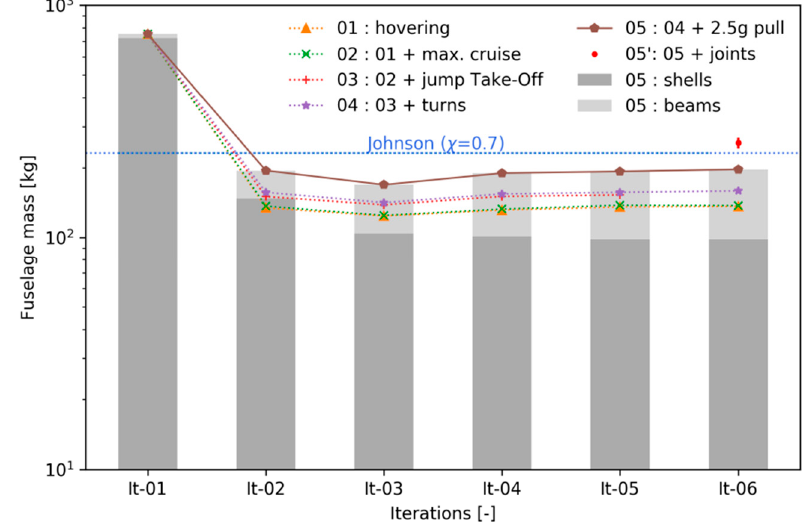
Figure 23. Structural sizing for a utility helicopter.